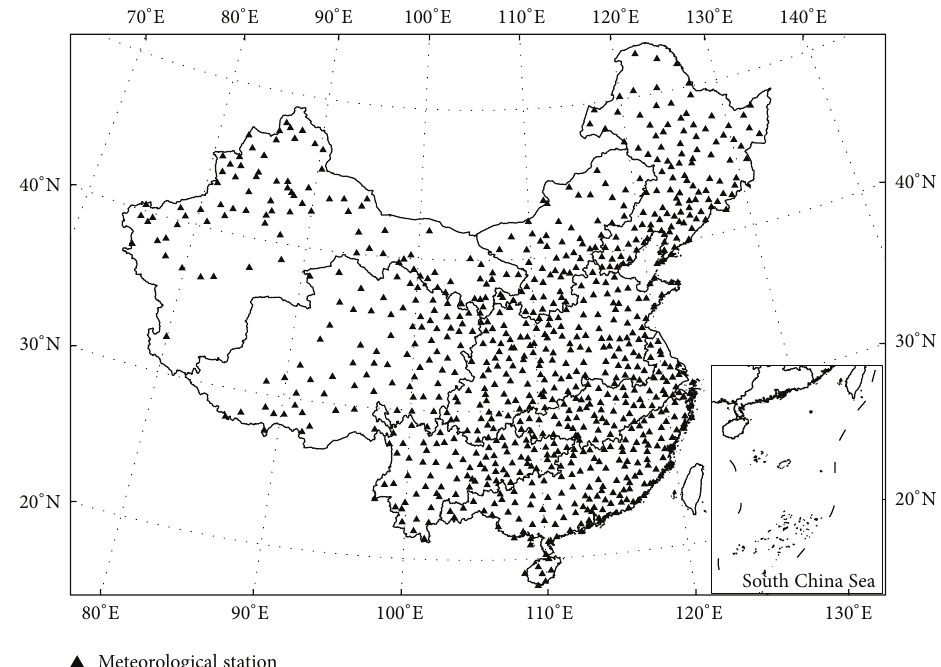
Figure 1: Geographic location of China and meteorological stations.